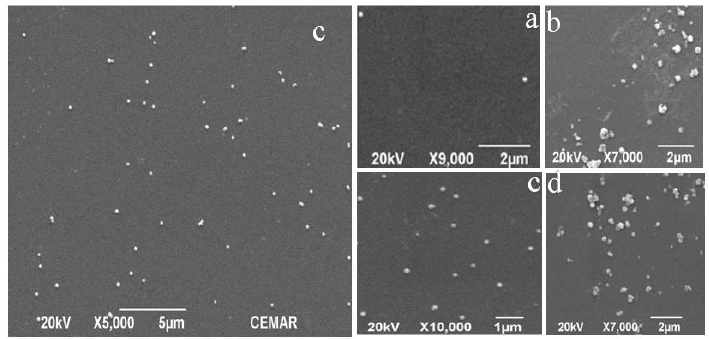
Figure 7. SEM images of four spin-coated samples: ( a ) 1000 r/min 30 s, ( b ) 600 r/min 30 s, ( c ) 600 r/min 10 s and ( d ) 0 r/min.